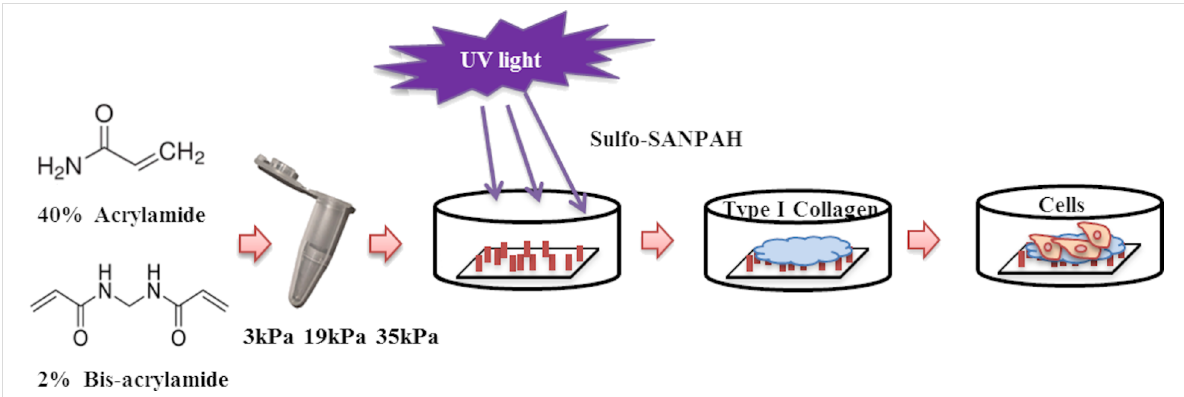
Figure 1: Schematic diagram of polyacrylamide hydrogel substrate preparation and cell culture process.